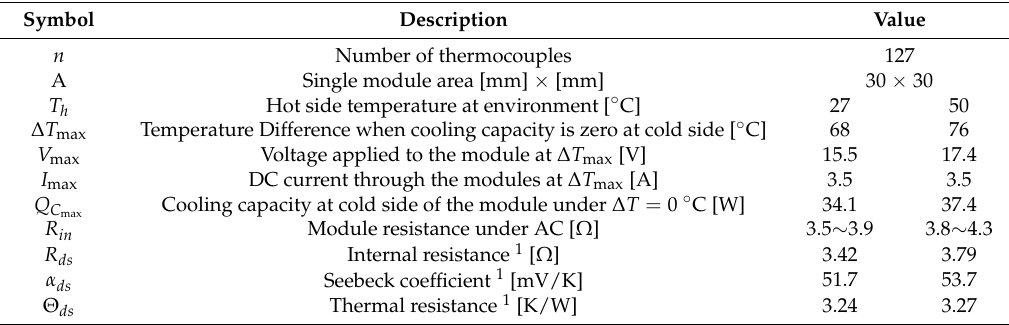
Table 3. TES1-12730 Parameters.